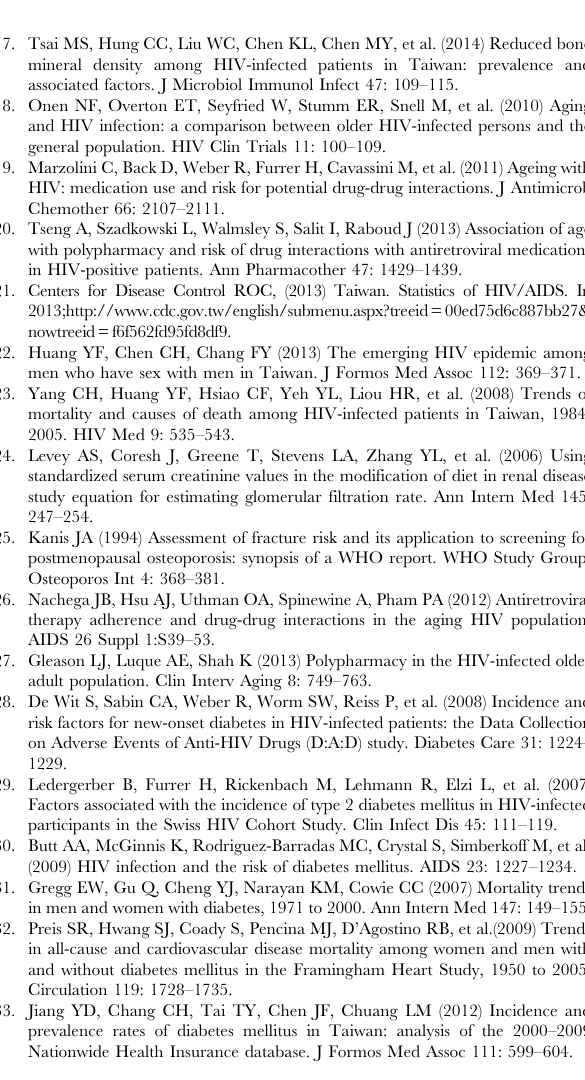
Figure S1 The scattered plot of glycosylated hemoglobin (HbA1C) and fasting glucose data collected from the 85 patients with diabetes mellitus during the 12-month study period. PI, protease inhibitor-containing regimens. Table S1 Comparisons of demographic and clinical character- istics of the patients with and those without diabetes